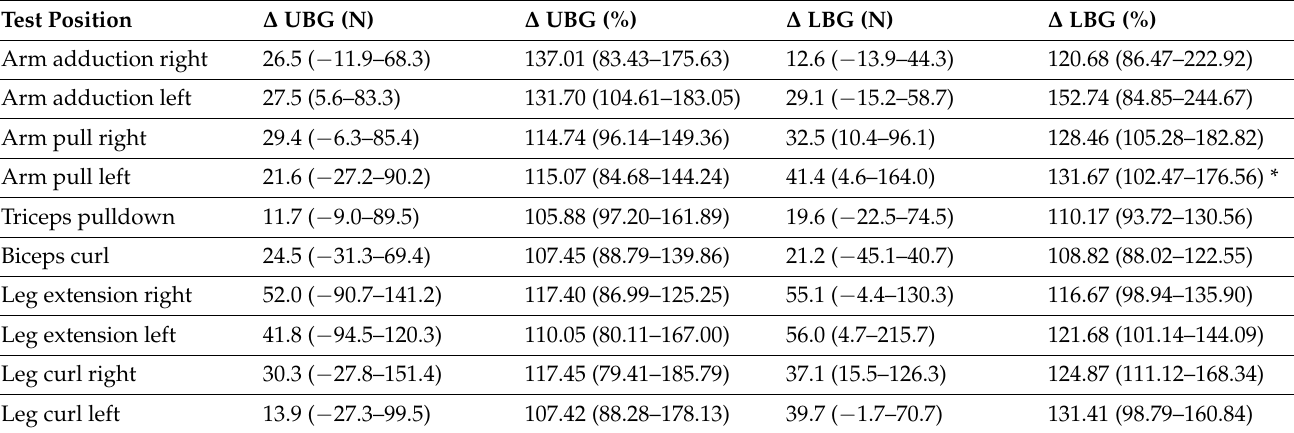
Table 4. Median differences (ranges) between final and initial maximum strength values in both groups (UBG and